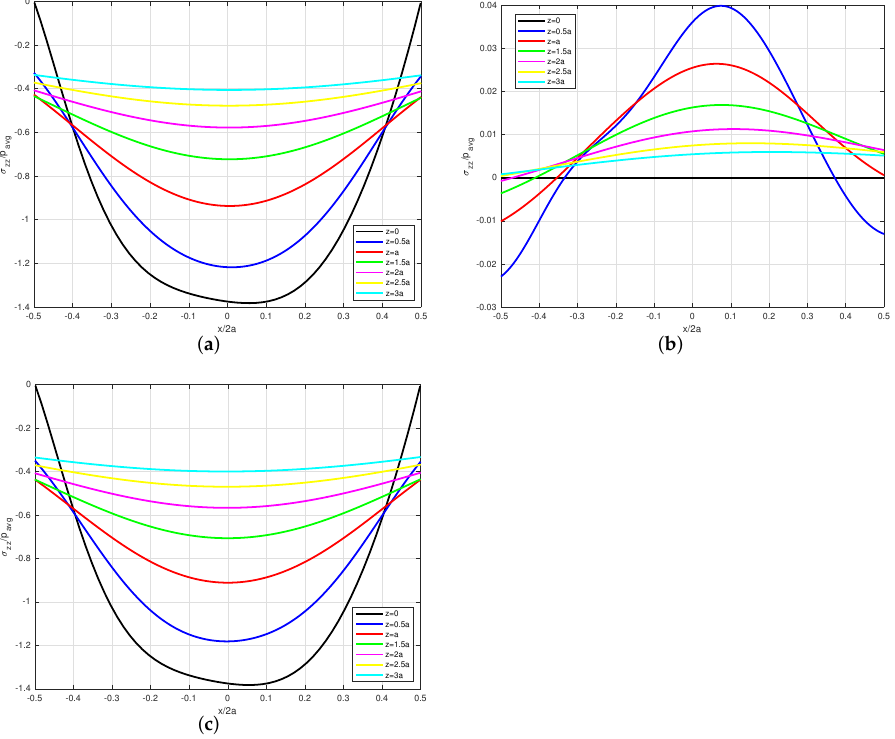
Figure 9. Vertical stress σ zz at various depths due to ( a ) normal component of boundary traction p ( x (cid:48) ) ; ( b ) tangential component of boundary traction q ( x (cid:48) ) ; ( c ) both p ( x (cid:48) ) and q ( x (cid:48) )